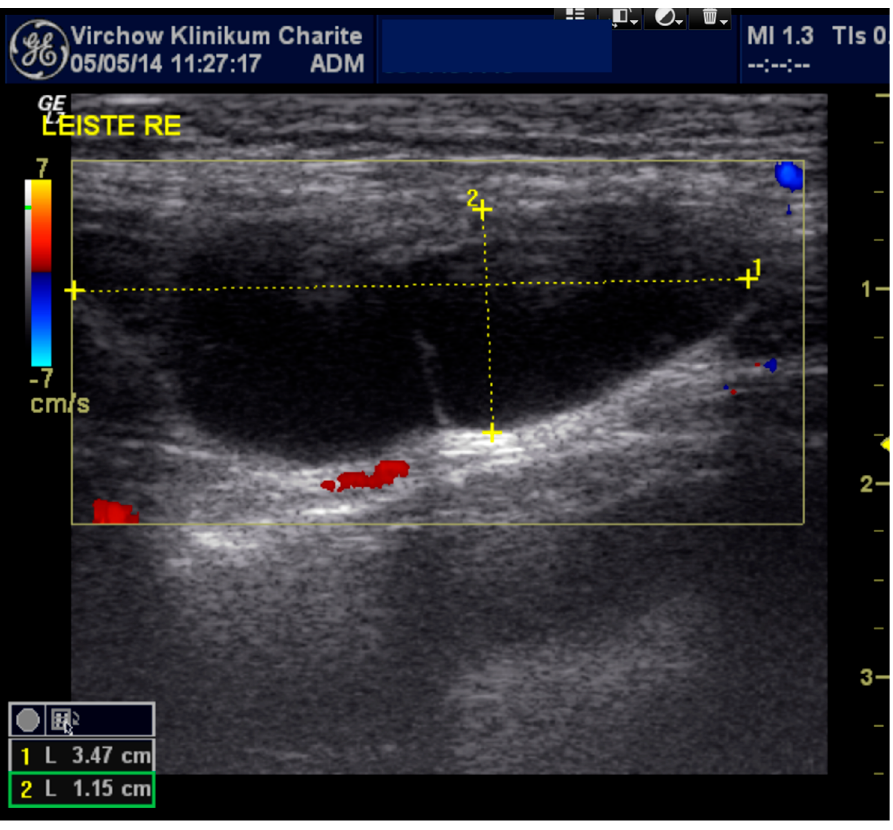
Figure 1. Sonographic imaging of the right inguinal area: anechoic elongated fluid structure (3.47 × 1.15 cm.